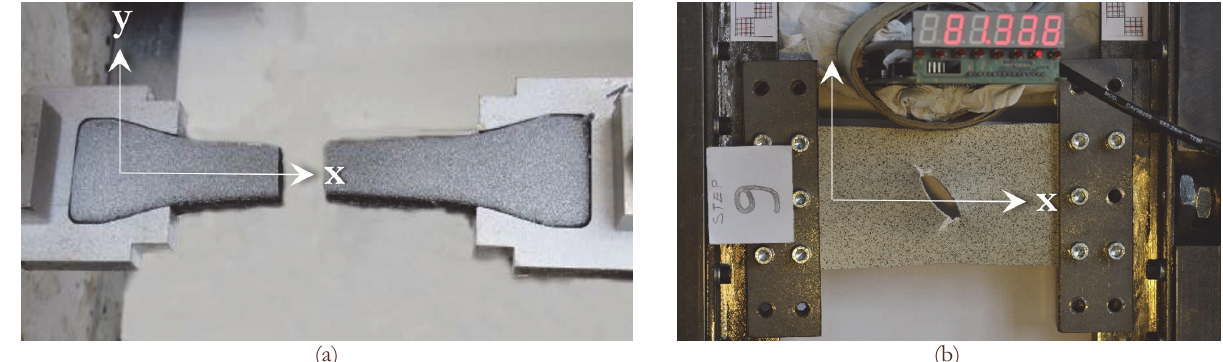
Figure 1: (a) Modified direct tension test for a mastic specimen at failure; (b) Tensile test for a polylactic specimen. A full-format Nikon D3X (6048x4032 pixels) digital camera, with 105 mm lens and 6 micrometers pixel size, was used